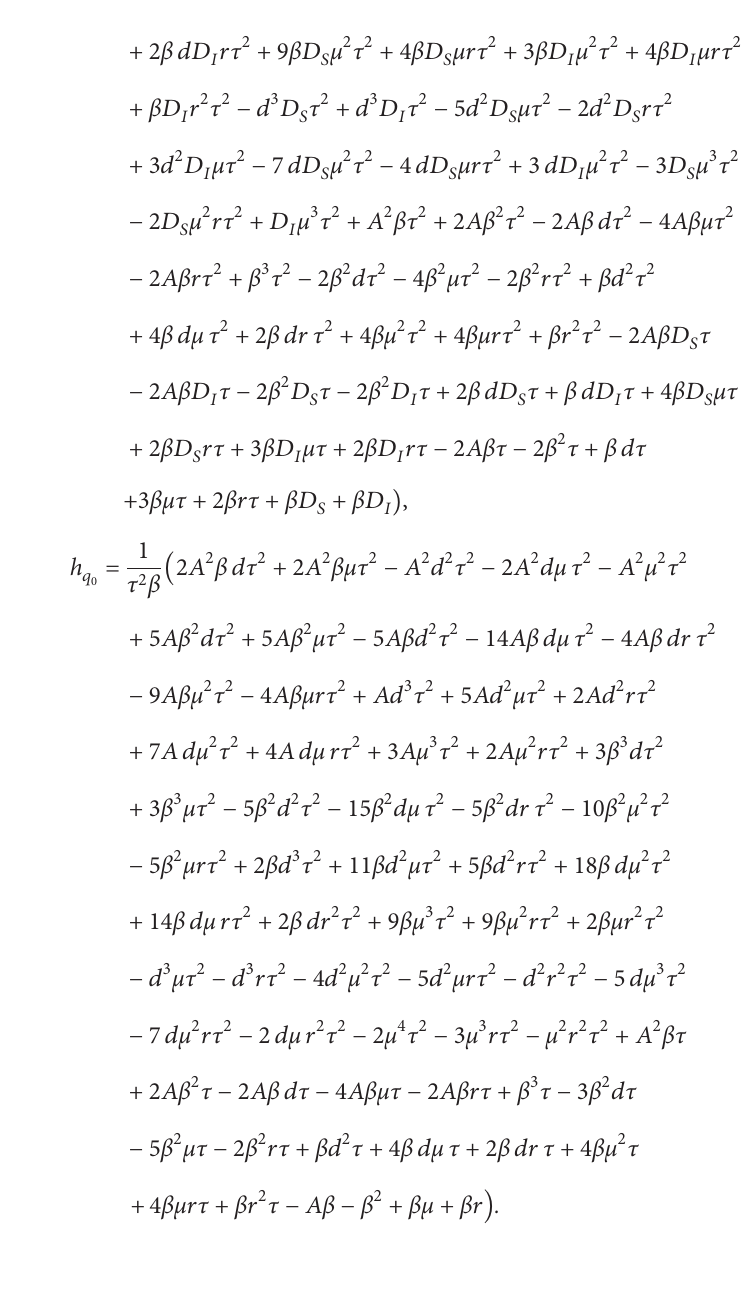
( z ) in Theorem 1: (a) case (i) and (b) case 2